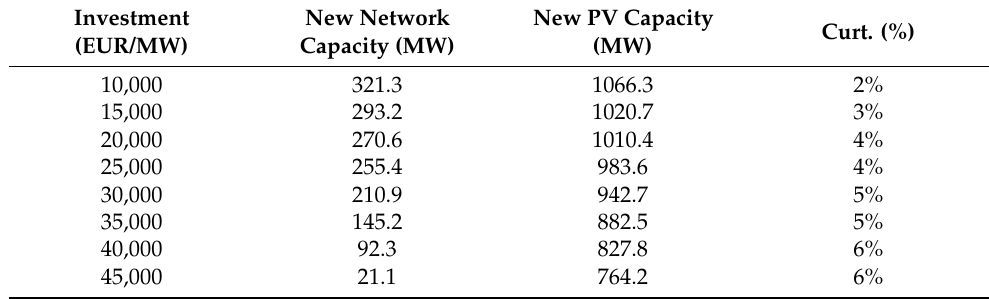
Table 3. Results for the first period.